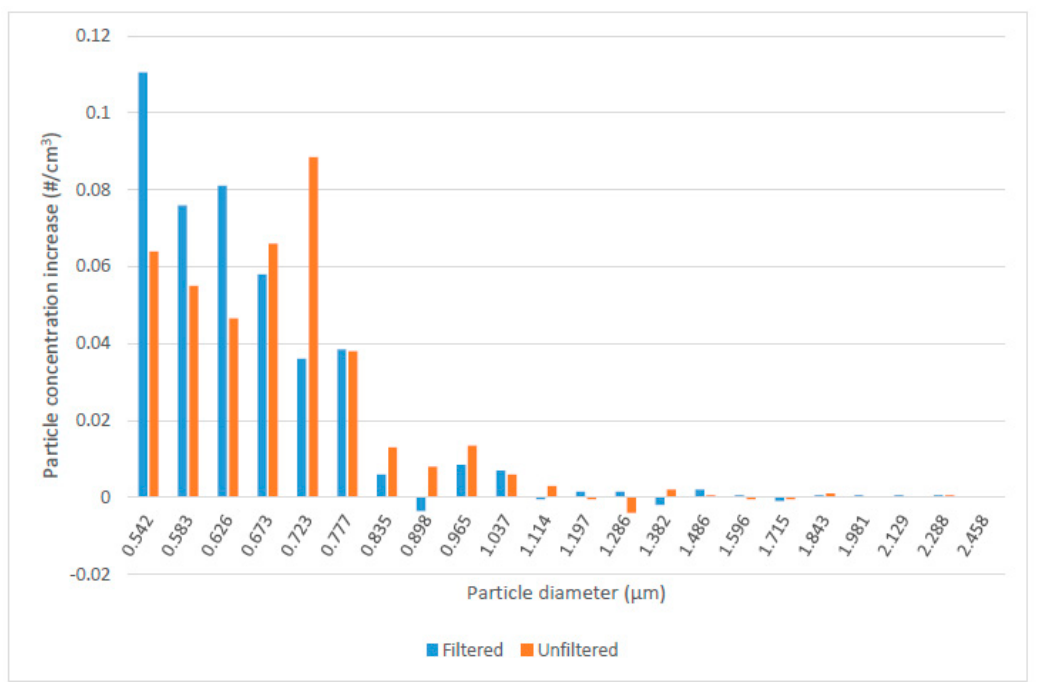
Figure 5. Effect of HEPA filtered versus unfiltered compressed air on generation of particulate at various sizes with 5 min of UV exposure and 1 min of recirculation (initial toluene concentrations 55 to 85 mg/m 3 ).